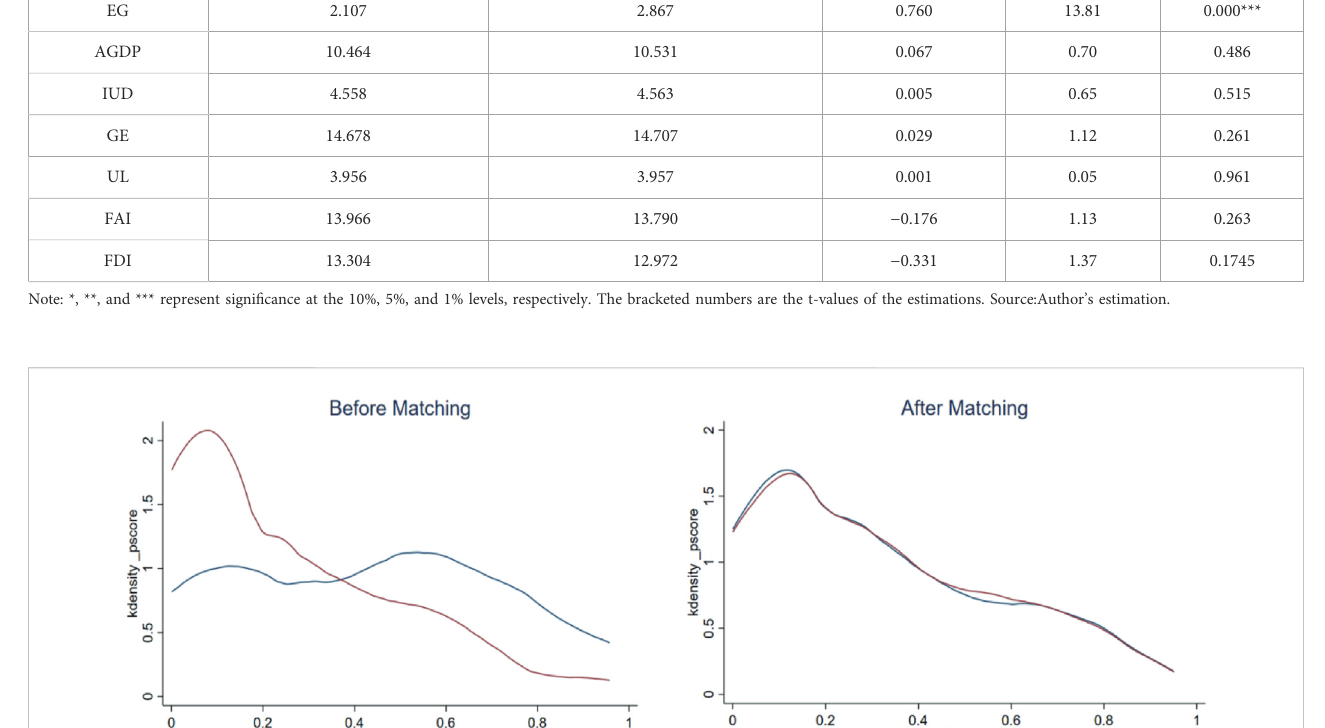
TABLE 5 Results of PSM-DID robustness test. Difference between experimental group and control group before rail transit opening